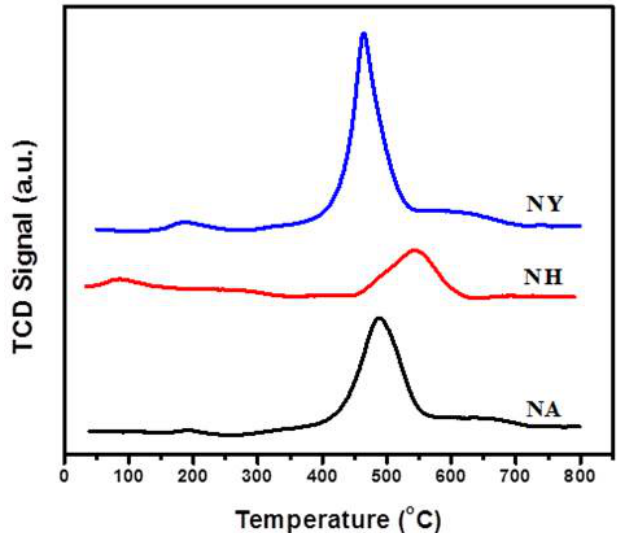
Figure 3. XRD patterns for Ni supported on alumina (NA), Ni supported on Y-zeolite (NY), and Ni supported on H-ZSM-5 (NH) fresh and Ni supported on alumina (NA) used catalysts.